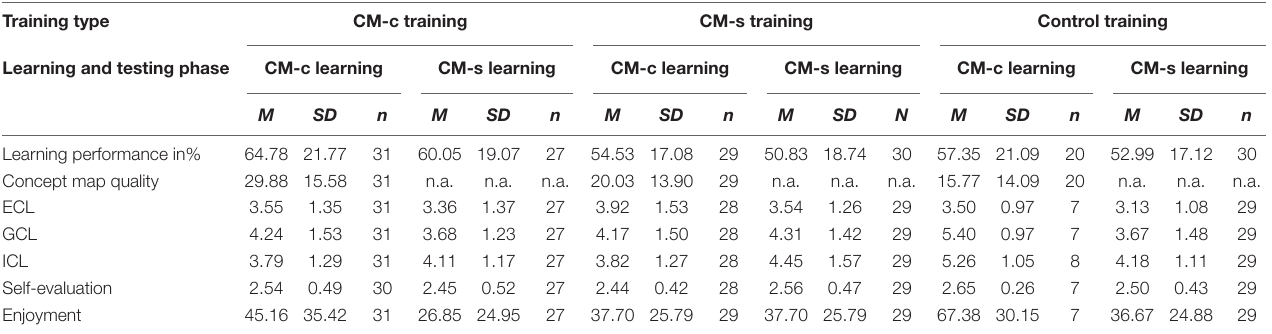
TABLE 1 | Means and standard deviations for learning performance, concept map quality, cognitive load, self-evaluation and enjoyment separate for training type and learning and testing phase.